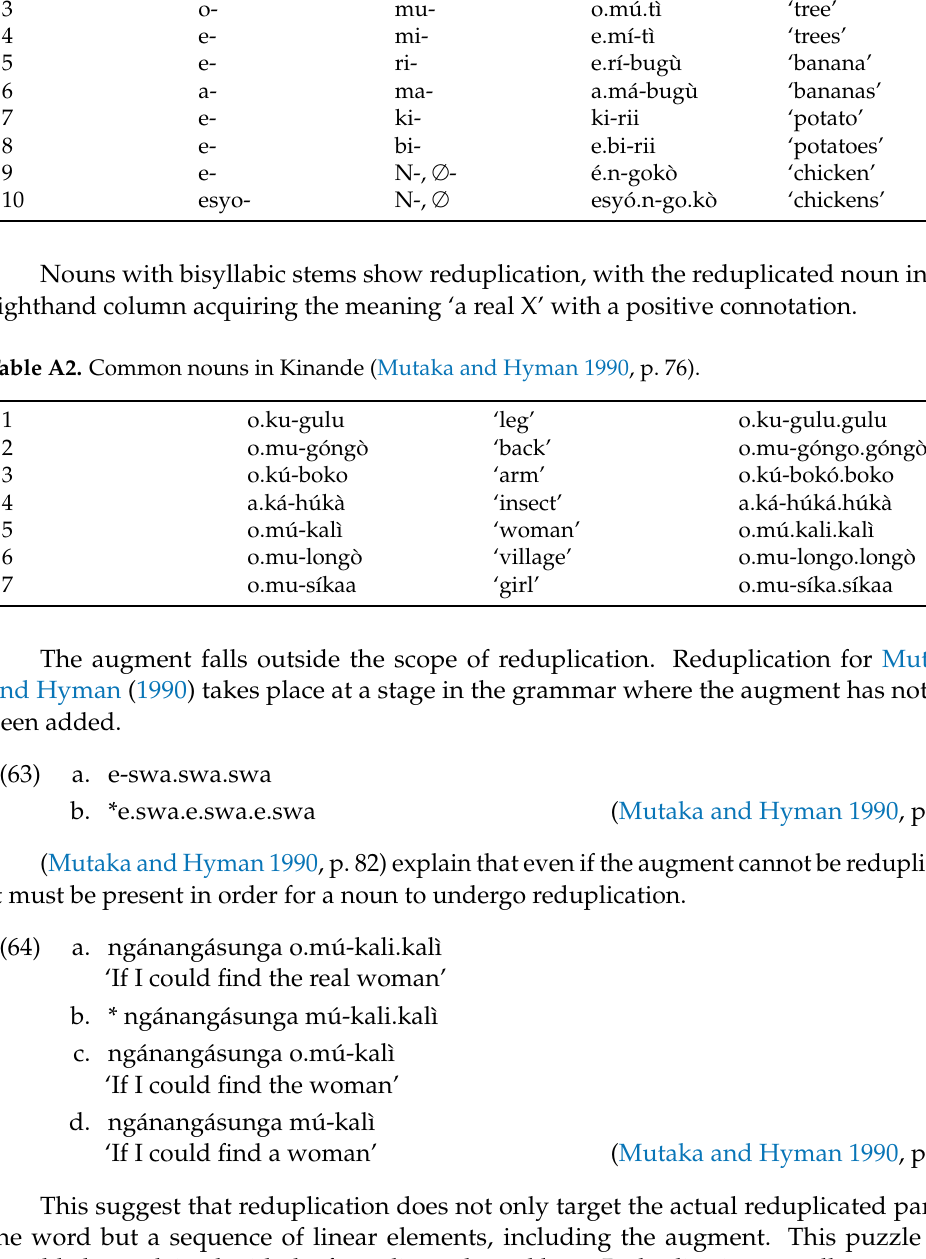
Table A1. Common nouns in Kinande (Mutaka and Hyman 1990, p. 75).